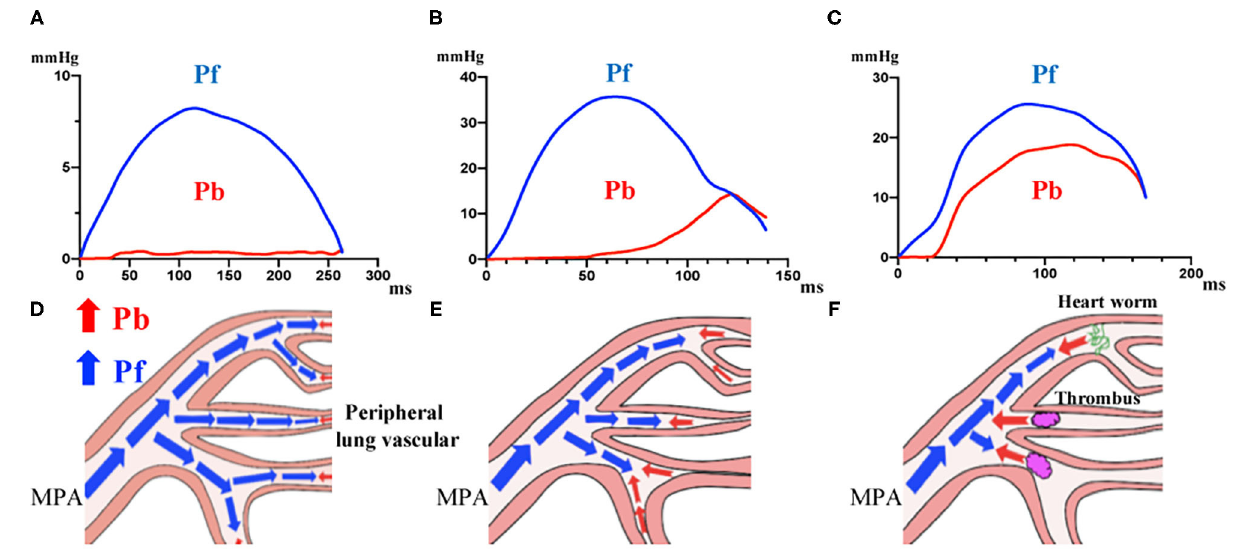
FIGURE 4 | Waveforms in dogs grouped in different categories. (A) , Dogs without echocardiographic evidence of PH. (B) , Dogs with suspected PH and no definitive diagnosis. (C) , Dogs with suspected PH due to thrombosis/heartworm disease. (D–F) , Schema representing the place where wave reflection appears in each group. PH, Pulmonary